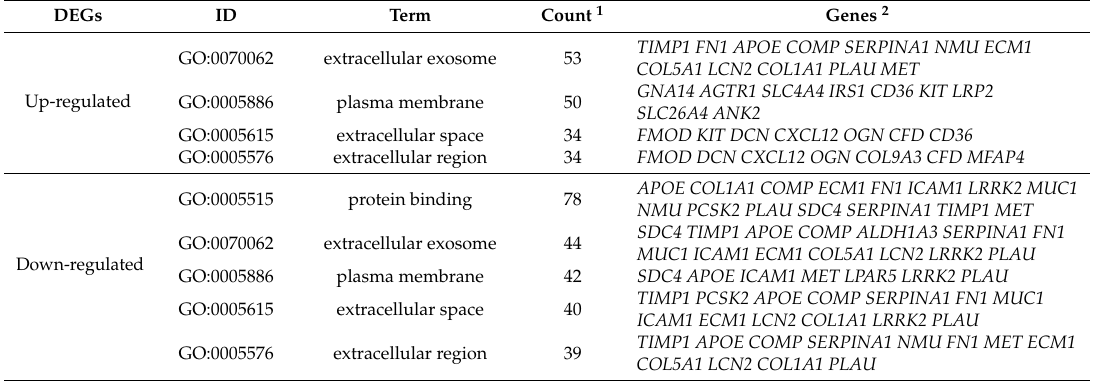
Table 3. Gene Ontology (GO) enrichment analysis of DEGs.